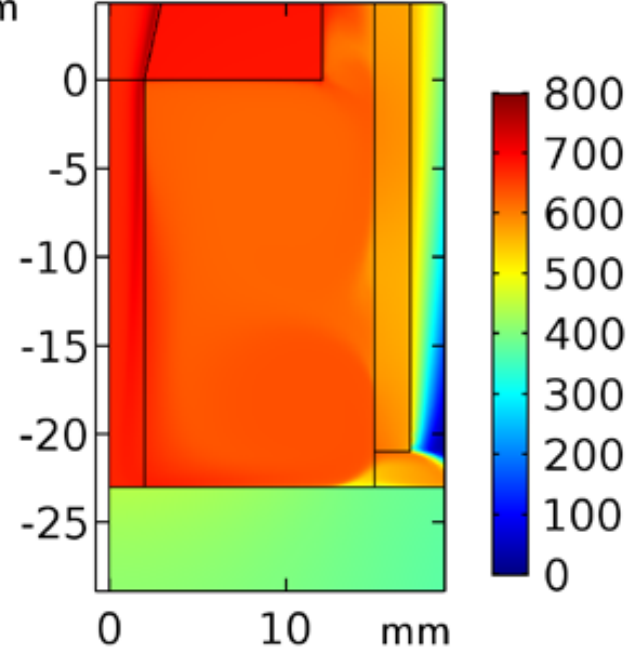
Figure 3. Temperature contour of inlet N 2 with 10 − 3 O 2 in the quartz tube